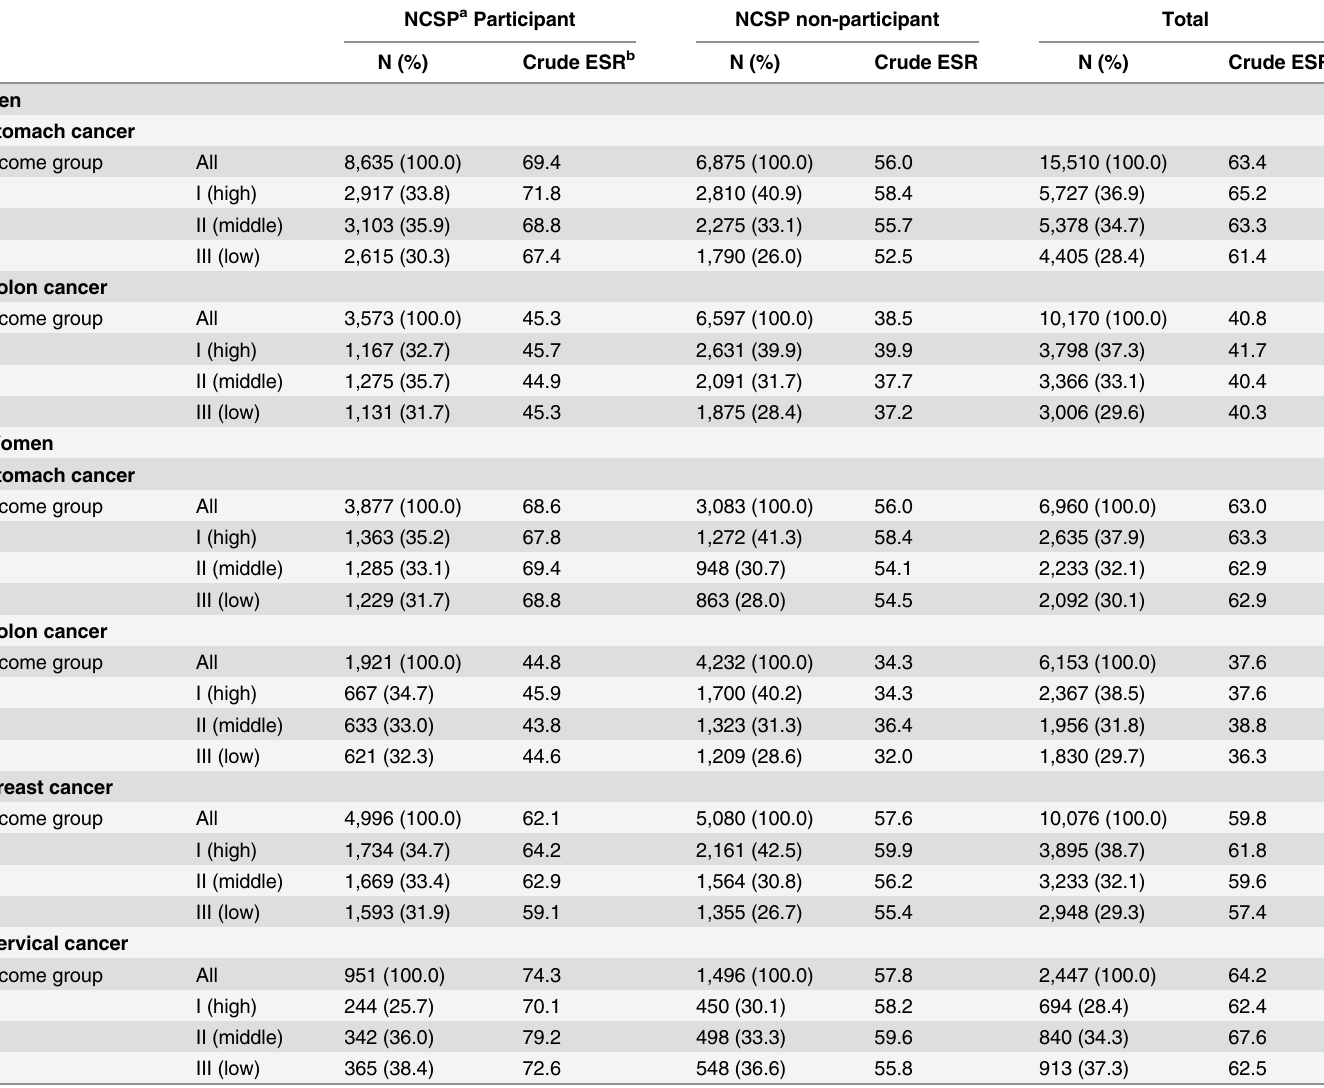
Table 2. Gender, cancer and National Cancer Screening Program participation specific numbers of study subjects and crude early-stage rate (%) by income